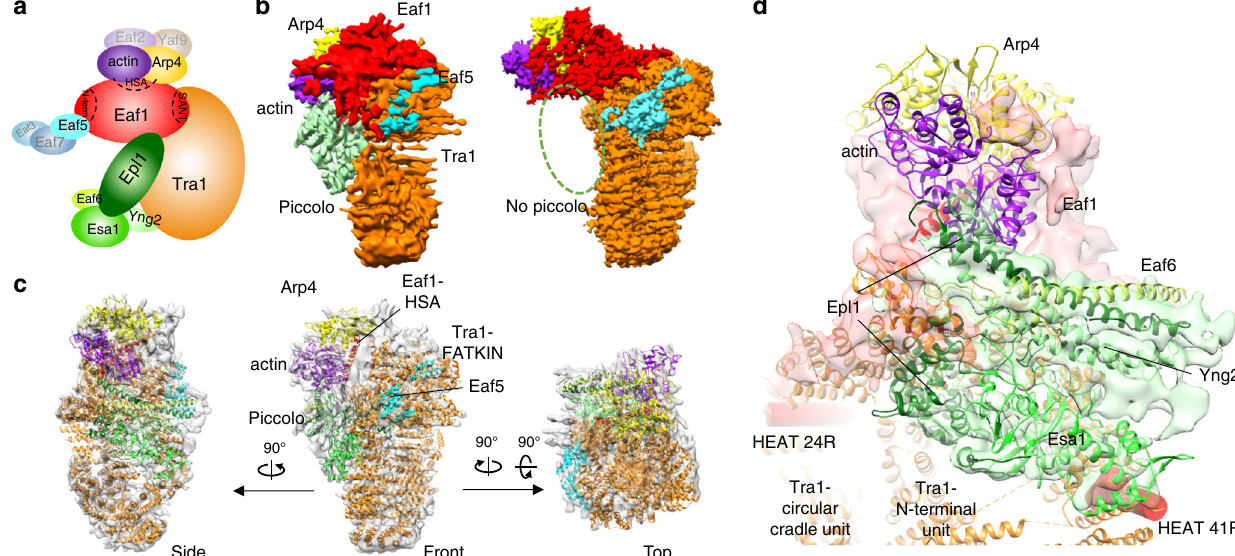
Fig. 5 Architecture of the NuA4 TEEAA-piccolo assembly. a Schematic view of subunit and modular organization of the NuA4 complex, highlighting the subunits present in the TEEAA-piccolo assembly. b Comparison of the cryo-EM structures of the TEEAA-piccolo and TEEAA assemblies in the front view. The density map is color coded by subunit assignment as panel a . The green dashed oval indicates the binding position of the piccolo module. c Three views of the TEEAA-piccolo assembly. The cryo-EM density is shown as a translucent surface and fi tted with the ribbon diagram model of the piccolo crystal structure (PDB ID 5J9U). Arp4 is in yellow, actin in purple, Tra1 in orange, HSA domain of Eaf1 in red, Eaf5 in cyan, and the piccolo module in green. Each successive view is rotated as indicated. d Enlarged view of the piccolo assembled into the NuA4 complex. Epl1 is in dark-green, Esa1 in lime, Eaf6 in yellow-green, and Yng2 in light-green. Piccolo interacts with both Eaf1 and Tra1 subunits. The Tra1 HEAT 24R and 41R mainly responsible for piccolo binding are highlighted in red